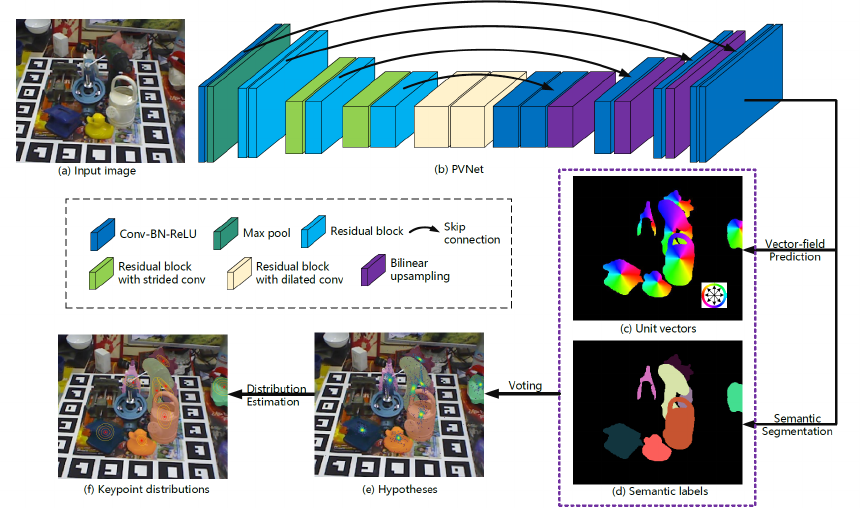
Figure 11. Overview of the keypoint localization in PVNet [72]. The probability distributions of the keypoint locations are estimated from